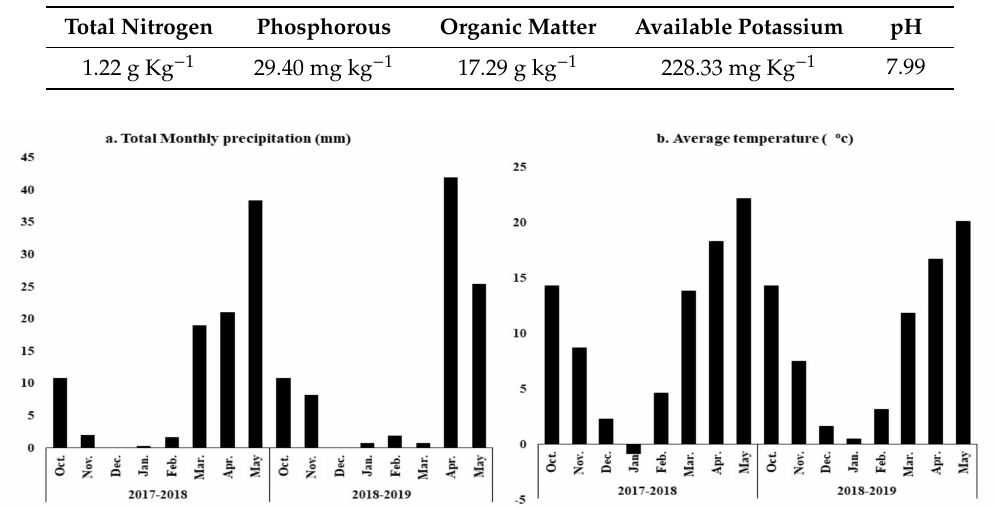
Table 1. Chemical properties.